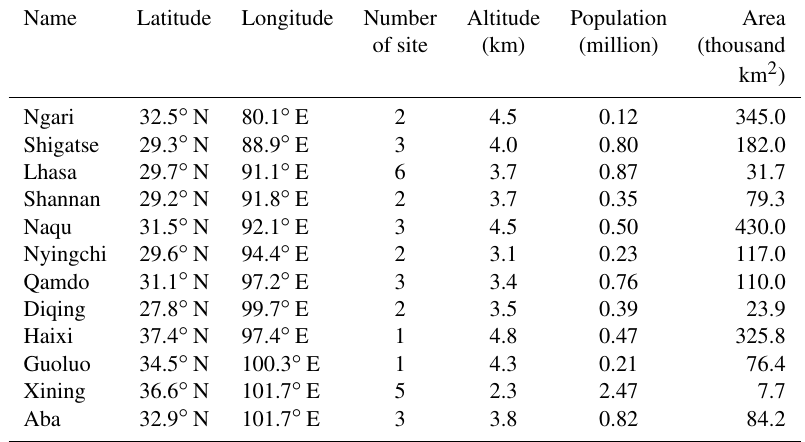
Table 1. Geolocations of each city over the QTP. Population statistics are available from the 2020 nationwide population census issued by the National Bureau of Statistics of China.